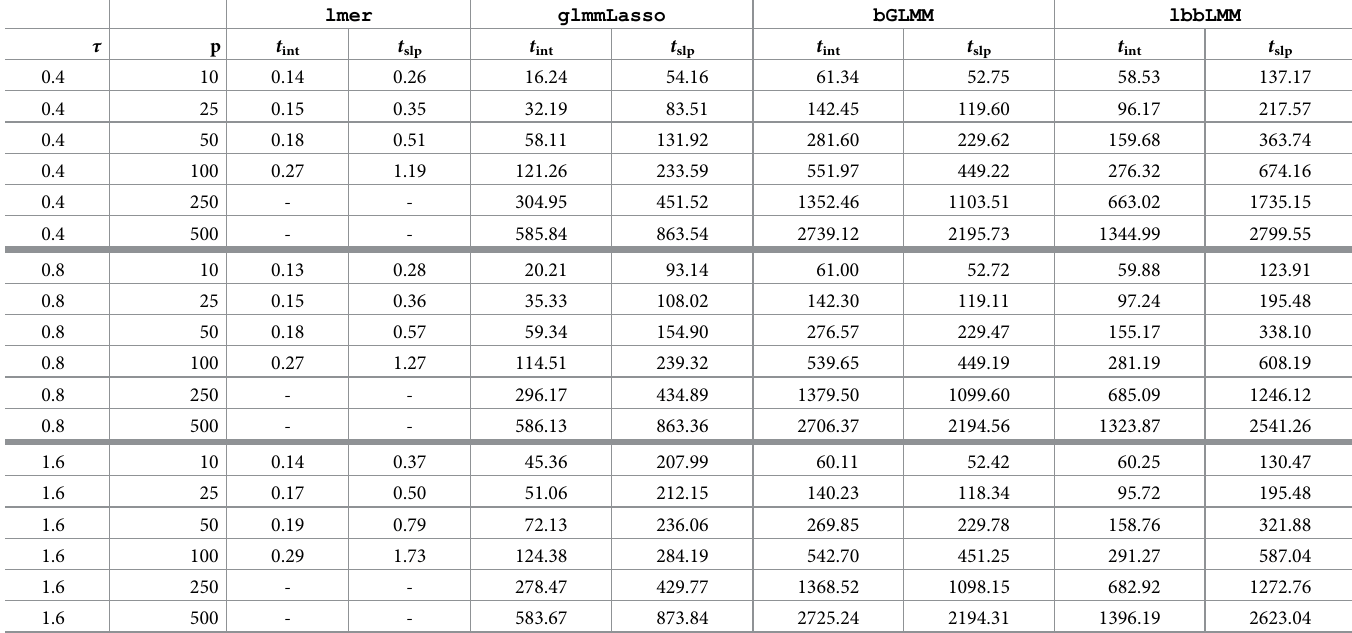
Table 7. Averages of elapsed computation time of 100 independent simulation runs for each random intercepts ( t int ) and slopes ( t slp ) setup.